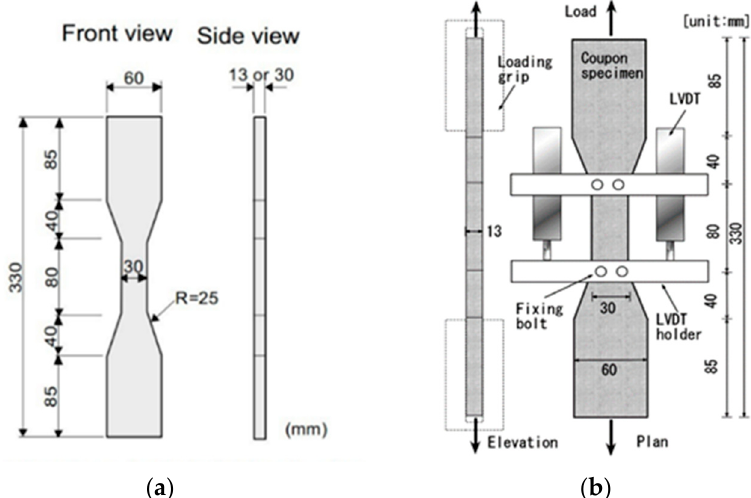
Figure 1. The specimen and device of the tensile test. ( a ) Tensile specimen; ( b ) Diagram of the tensile loading device